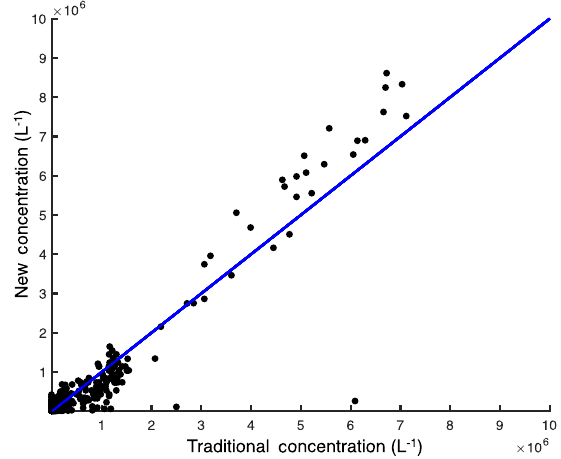
Figure 10. Traditional INP concentration vs. new INP concentra- tion with 1:1 line for “ice-only”